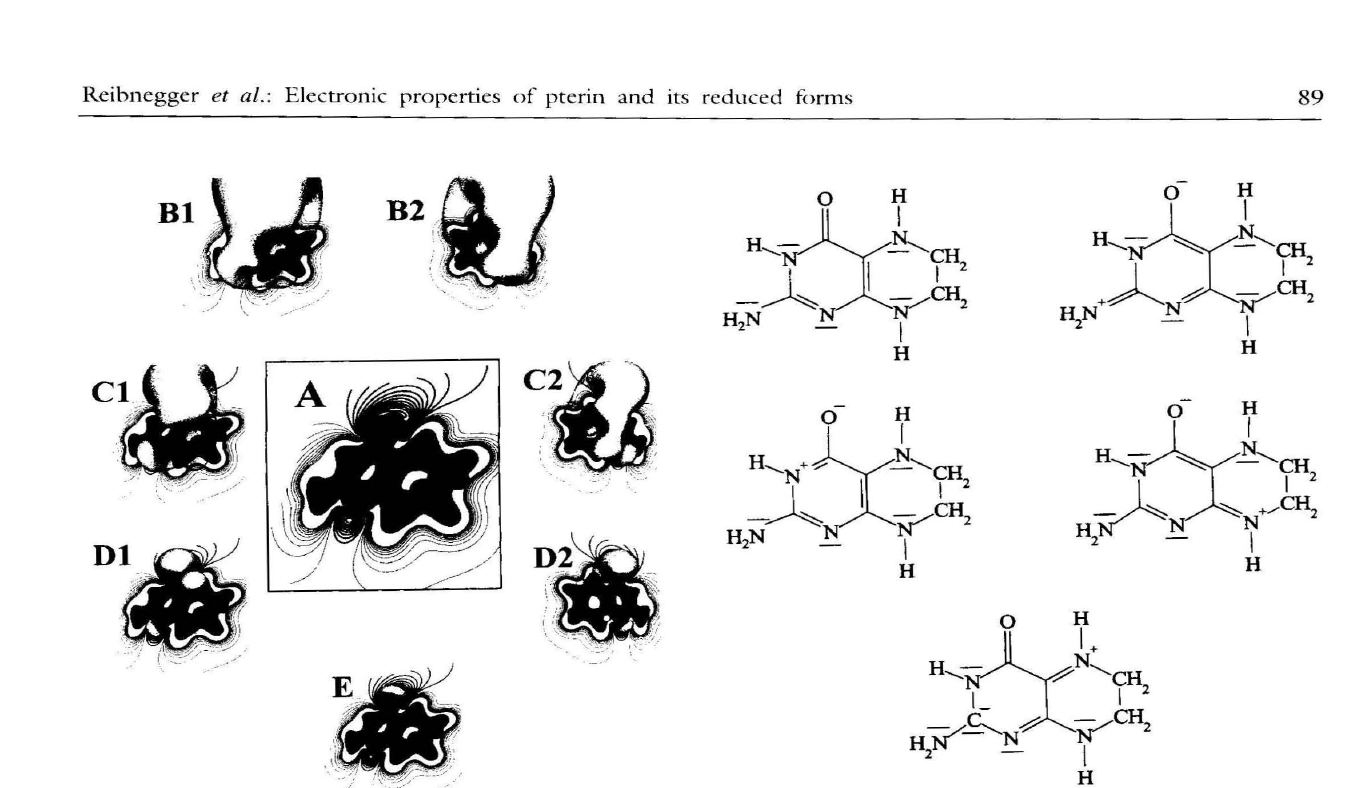
Figure 8. Some of the possible Lewis-structures of 5,6,7, 8-teu·ahydropterin indicating the involvement of the ni trogens N2', N3, N5 and N8 in the aromatic electron de